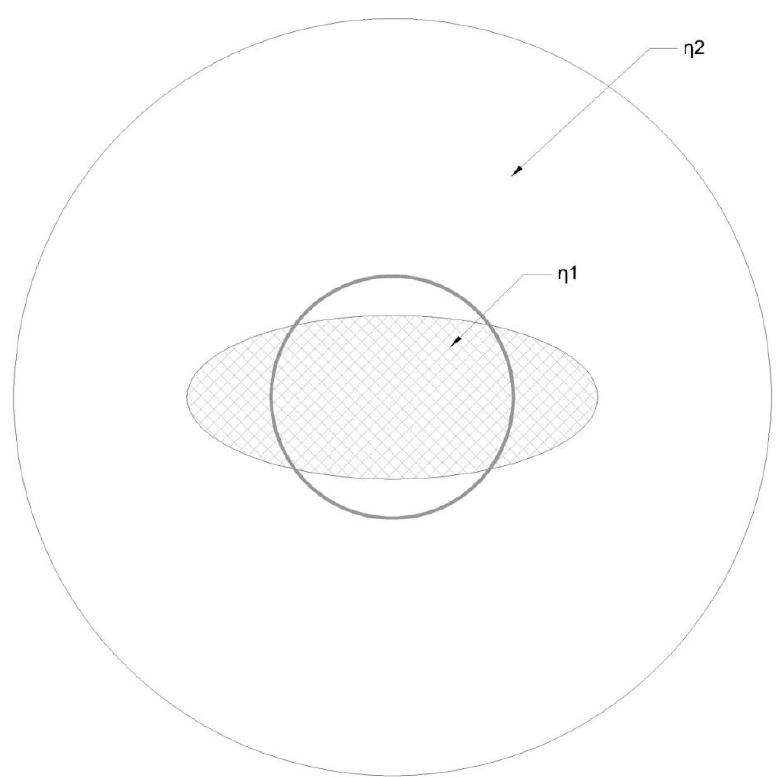
Figure 1. Example of the alternating character of the local index value from a thin shell radial discretization.